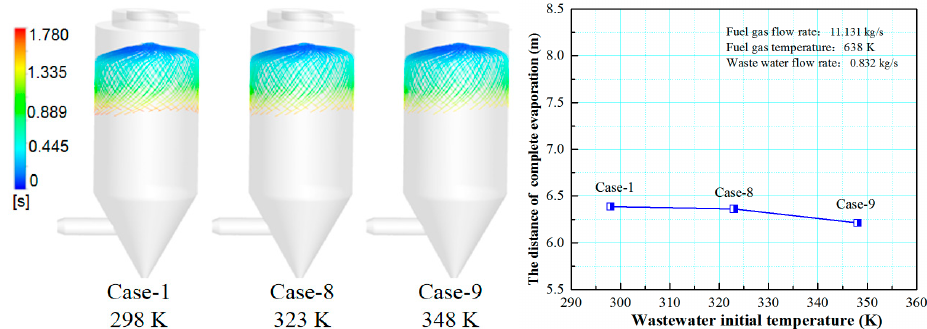
Figure 15. Effect of initial wastewater temperature on evaporation performance.